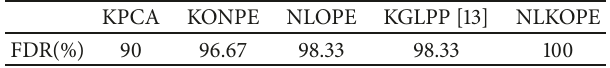
Table 2: Fault detection rates of five methods. Table 3: The clustering degree of different reduction